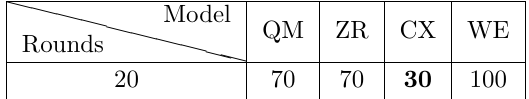
Table 7: Solving times for HIGHT over 20rounds depending on the modeling. Timings are given in seconds, over a subset of all cases.